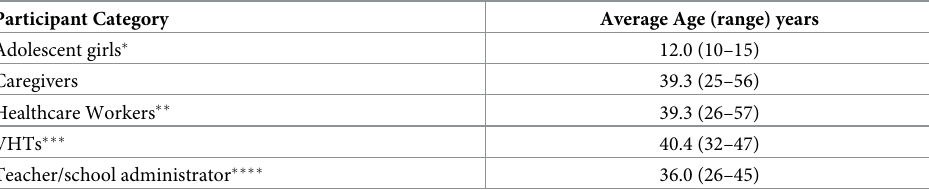
Table 2. Participant category and